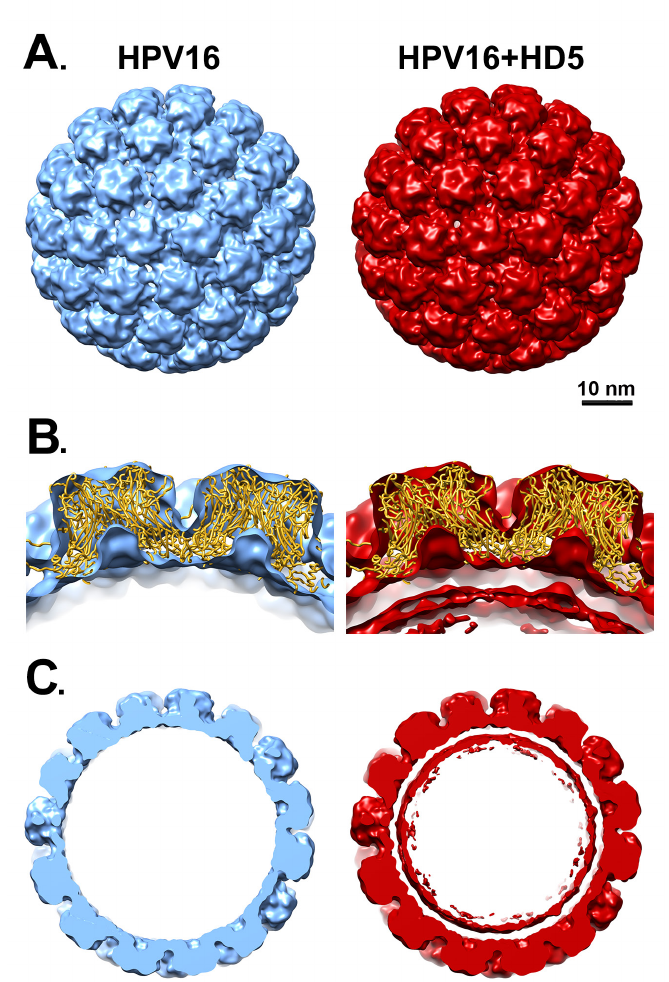
Figure 2. Filtered maps of HPV16 and HPV16+HD5. (A) Both cryoEM structures are shown filtered to 2 nm. Scale bar = 10 nm. (B) Cross-sectional views with docked L1 capsid coordinates (PDB: 5KEP) shown as a ribbon (gold) and oriented with the hexavalent L1 pentamer on the left and the pentavalent L1 pentamer on the right. In the HPV16+HD5 structure, additional density is observed below the L1 capsid. (C) Central slabs (10 nm thick) of both structures. Note the prominent internal core density below the L1 capsid in the HPV16+HD5